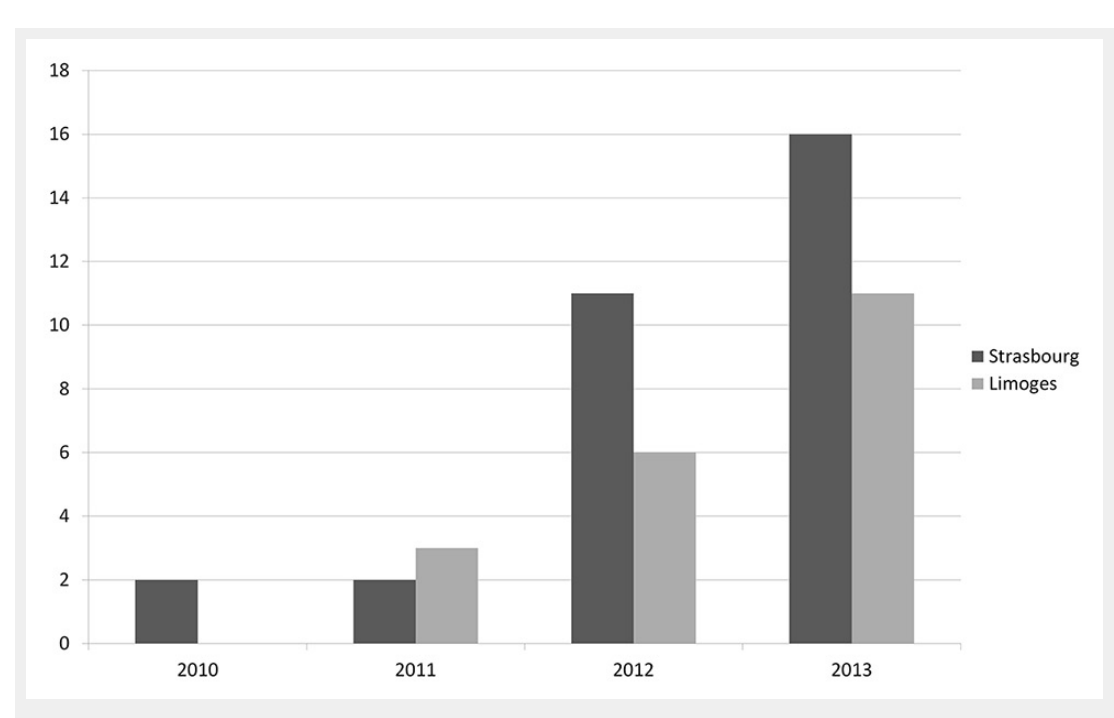
Figure 1 Number of Moraxella osloensis samples over time in the teaching hospitals of Limoges and